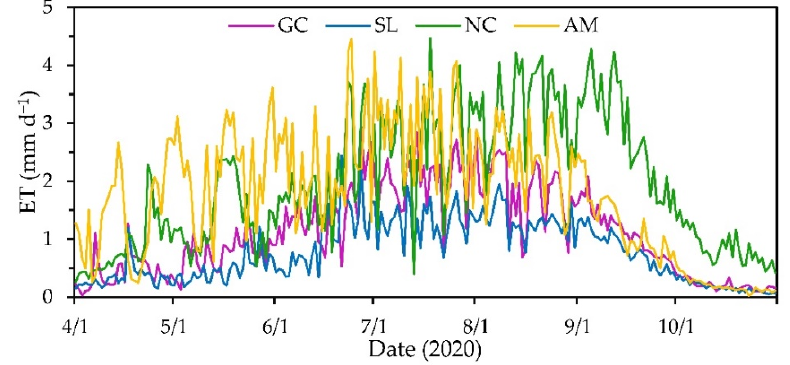
Figure 4. Trends of daily evapotranspiration at the four observation stations in the Qaidam Basin in 2020.